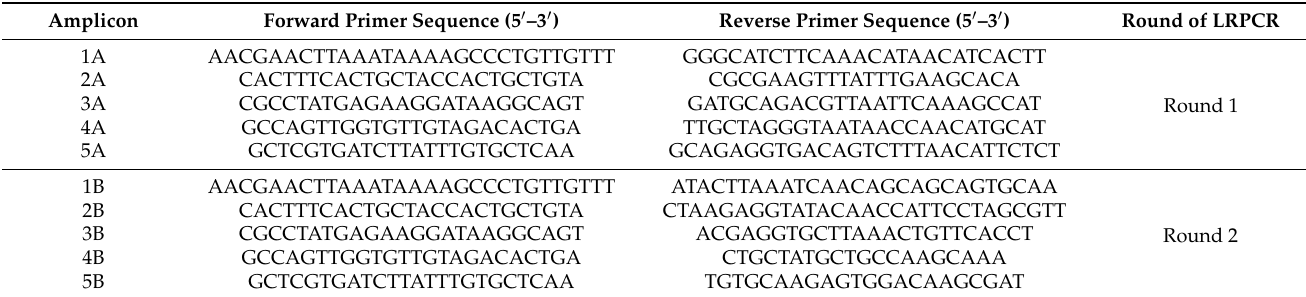
Figure 1. Location of five, approximately 6 kb, overlapping LRPCR amplicons spanning 99% of the MERS-CoV genome. Nucleotide positions relative to the 2012 EMC variant MERS-CoV reference genome, NCBI Accession #JX869059, are listed under each amplicon name for the first and second round (A and B, respectively) of the semi-nested LRPCR. Table 1. Primer sequences for each of five, approximately 6 kb amplicons, spanning the MERS-CoV genome. Each amplicon is the product of a semi-nested LRPCR.